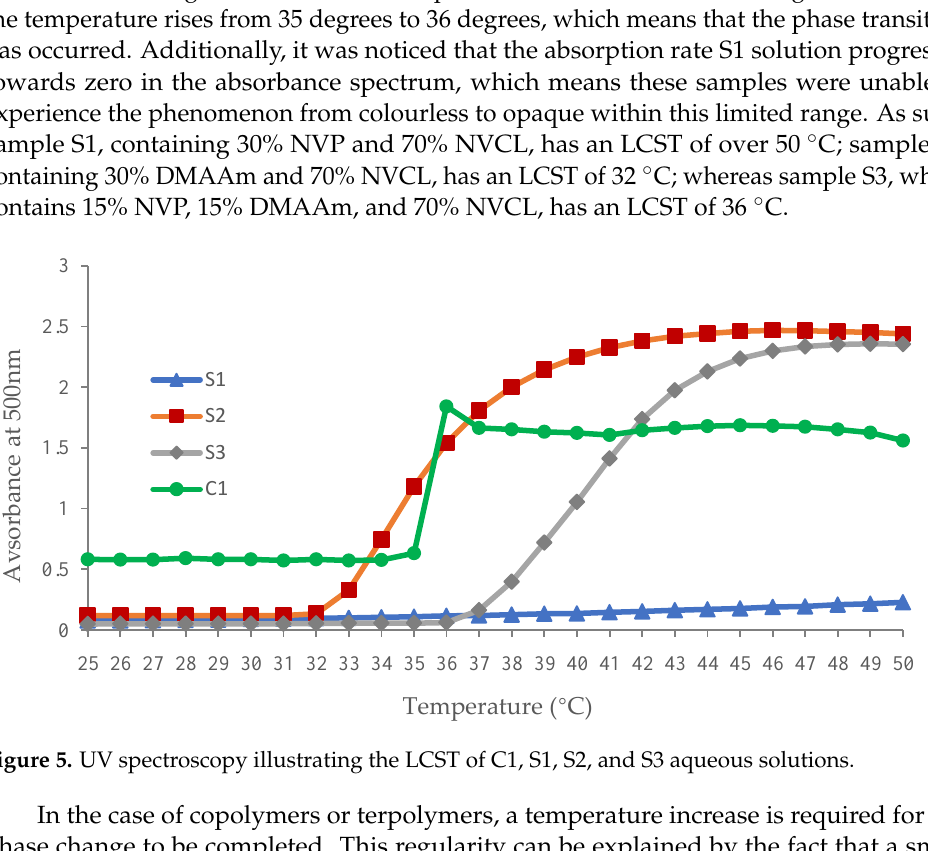
Figure 5. UV spectroscopy illustrating the LCST of C1, S1, S2, and S3 aqueous solutions.